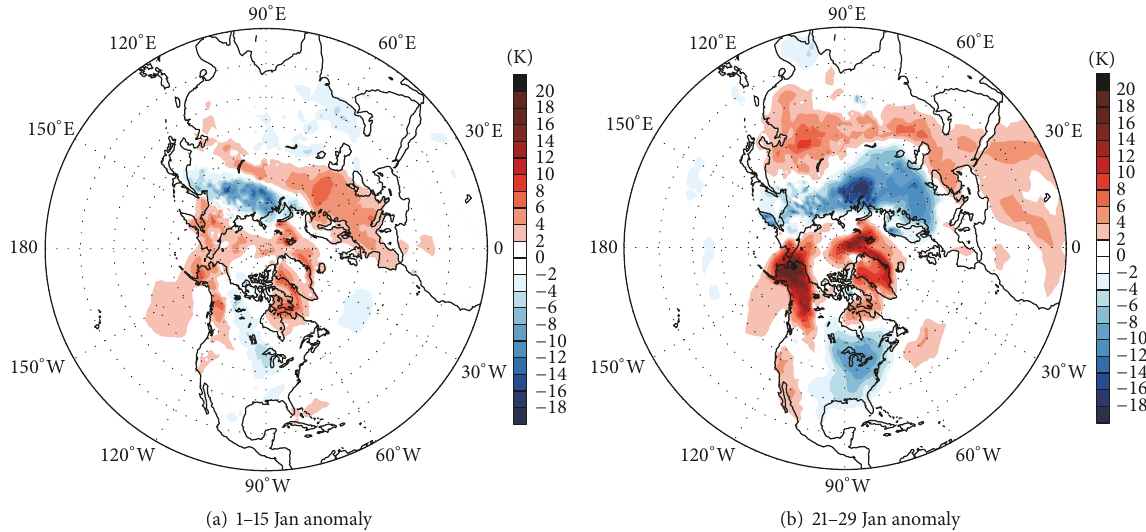
Figure 1: Composited 2-m surface temperature anomalies (shading; K) in January 2014 relative to the 30-year climatology: (a)